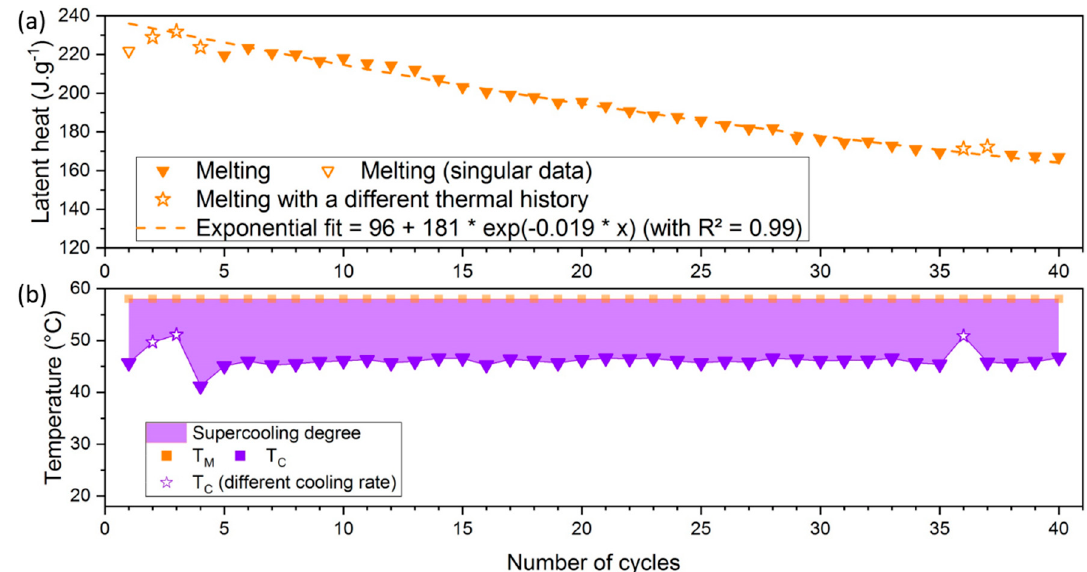
Figure 15. Evolution of ( a ) the latent heat and ( b ) the supercooling degree over 40 cycles of a SAT58% sample ( w SA = 0.577). Values for 3rd, 4th, 5th, 36th, and 37th are plotted as stars. As the open symbols (following a low-temperature crystallization), they will not be considered for exponential fit and aging analysis. T M and T C respectively represent melting and crystallization temperatures.